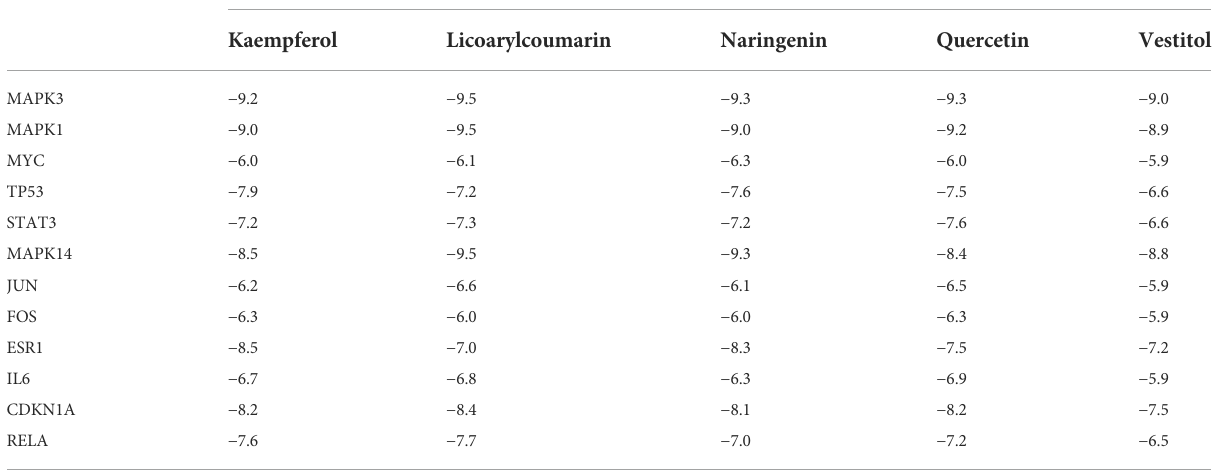
TABLE 3 Binding energy of main active components in ECD with hub targets.